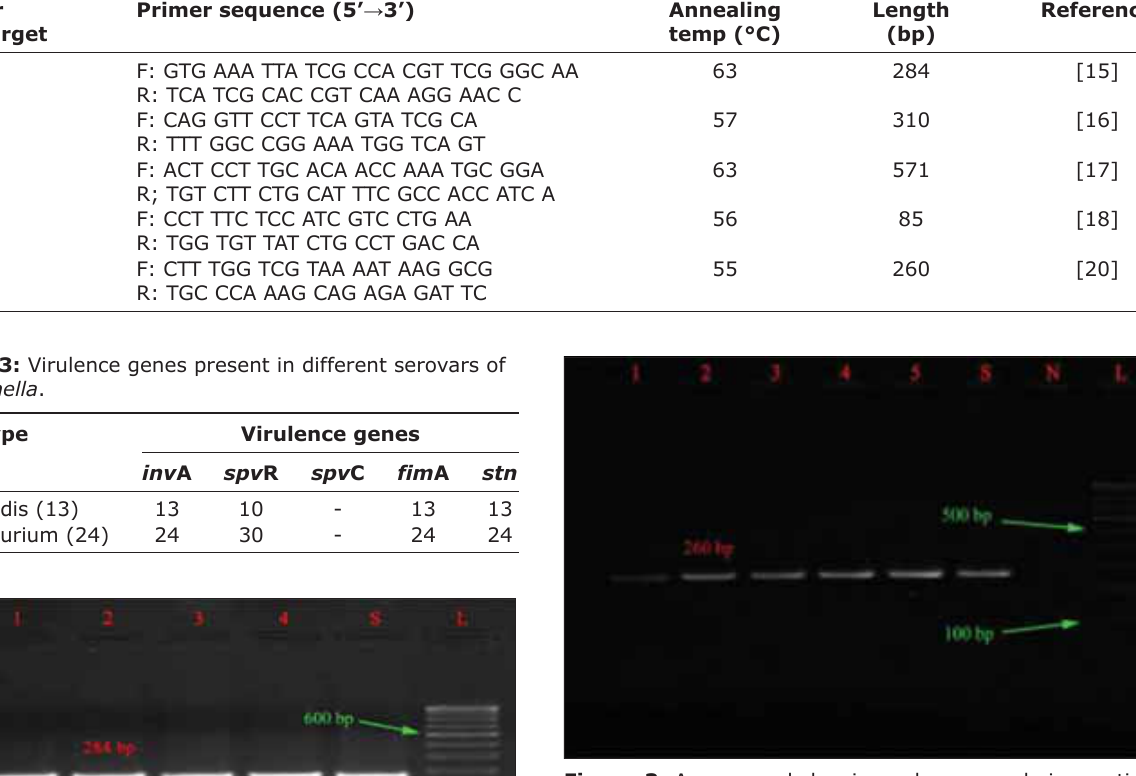
Table-2: Primer pairs used for virulence characterization of Salmonella isolates. Primer pair target